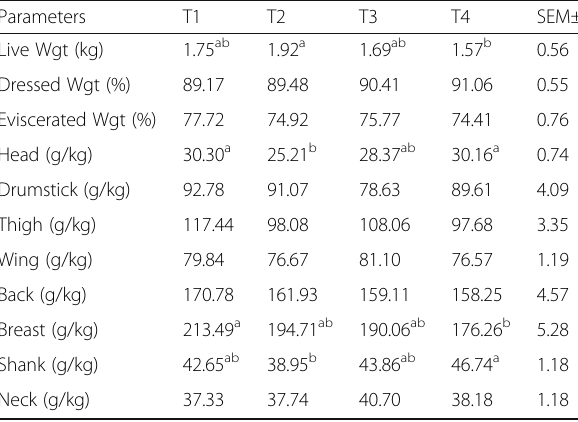
Table 4 Carcass traits measurement of broiler fed fungi treated cocoa pod husk meal